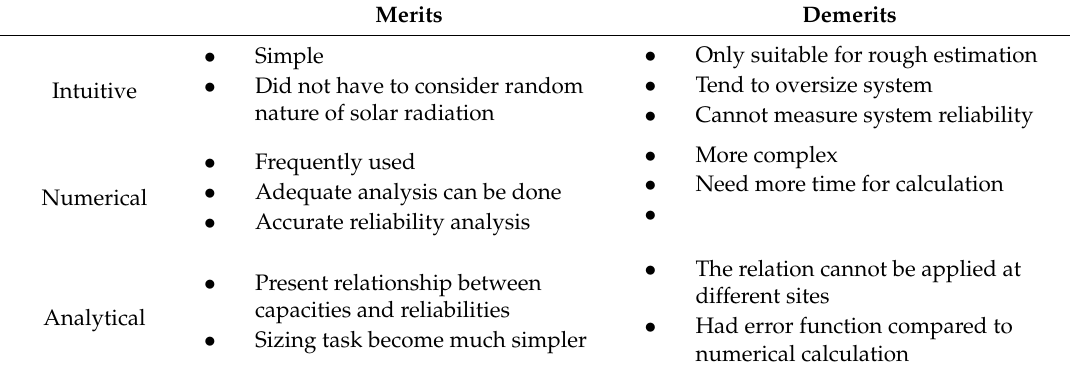
Table 1. Brief comparison on three main optimization